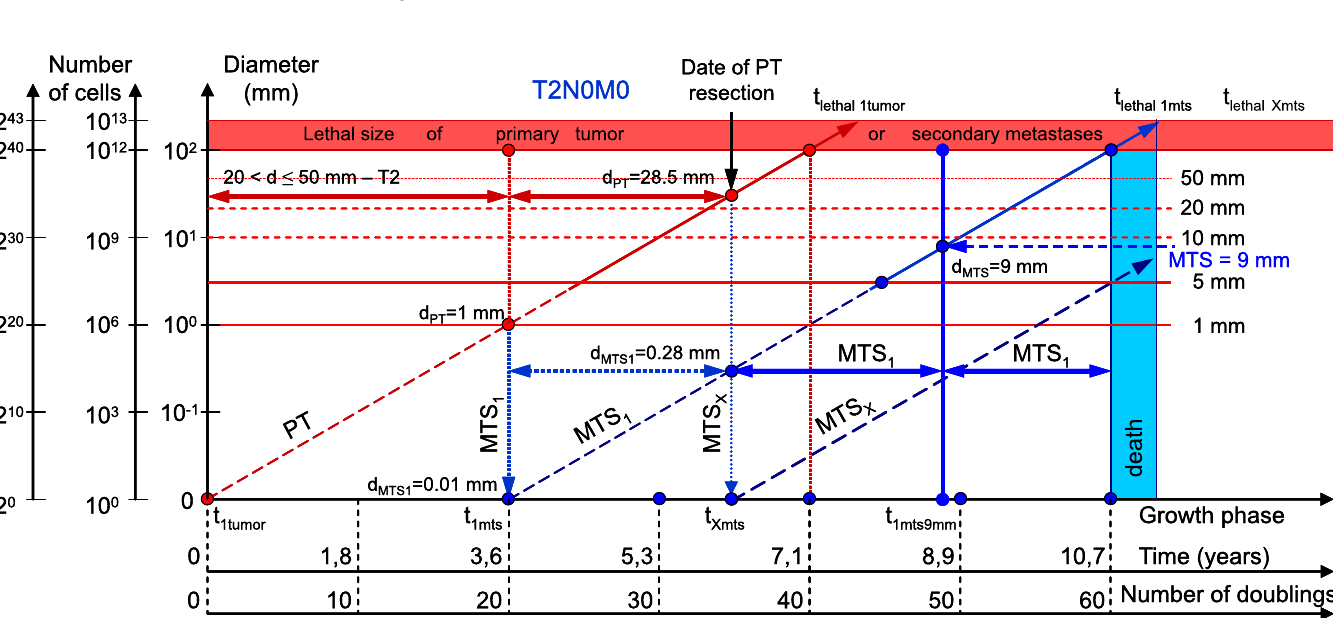
The survival of BC patients included both the non-visible and visible periods of MTS growth, whereas the non-visible was the period from the date of PT resection to the date of